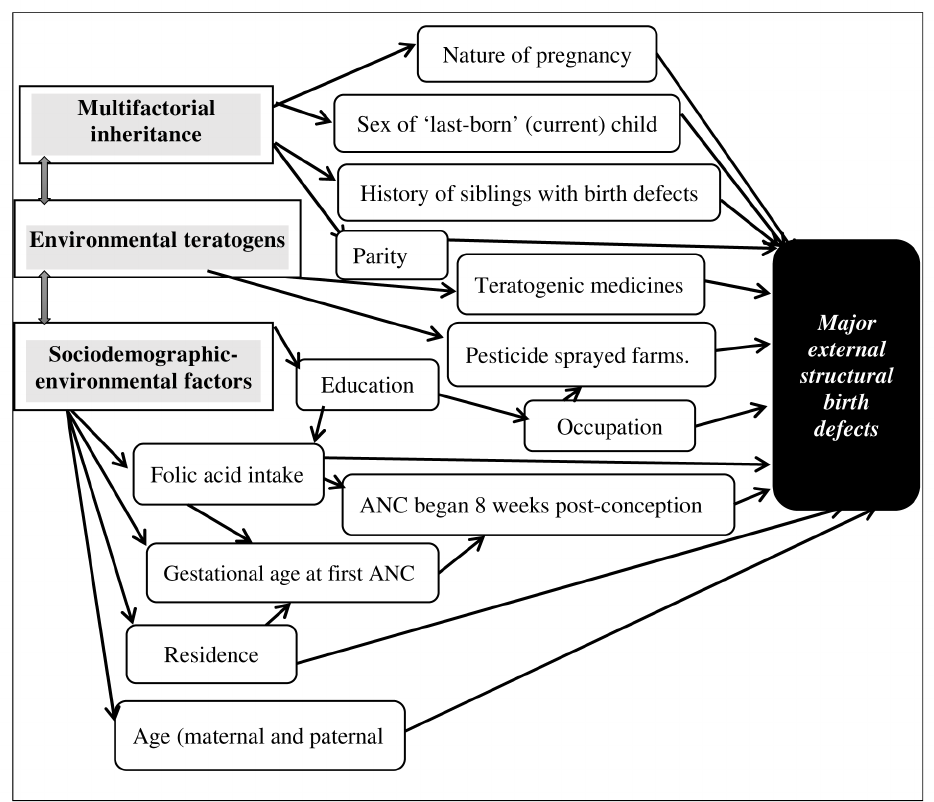
Figure 1. Causal diagram of factors thought to influence major external structural birth defects (MESBDs) among children in Kiambu County,